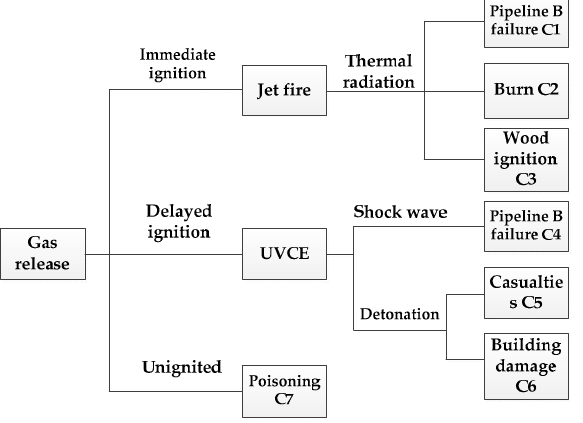
Figure 12. Natural gas pipeline failure event tree. 430